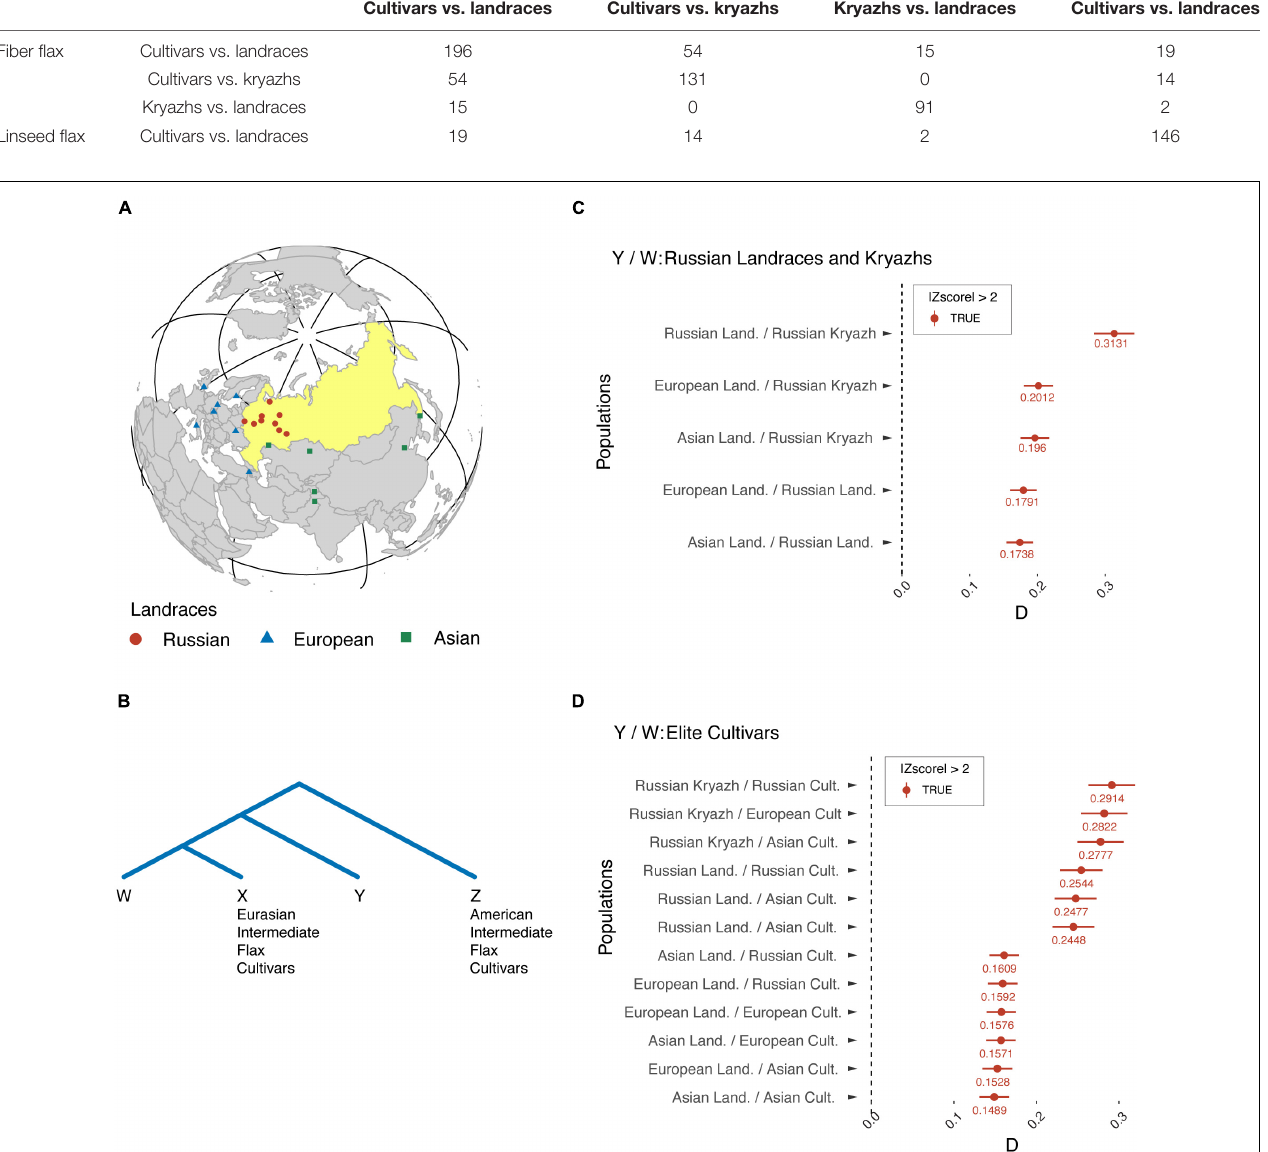
FIGURE 6 | Signatures of gene flow from European and Asian landraces into Russian landraces and kryazhs, as well as from kryazhs and landraces to modern flax fiber cultivars. (A) Geographic sites of landrace origin/release. (B) Four populations used to calculate D -statistics. Z , American intermediate flax cultivars; X , Eurasian intermediate flax cultivars; W , the second sister population; Y , the introgressing population. (C) D -statistics diagram where population W corresponds to kryazhs or Russian landraces, while population Y stands for landraces of different origin. (D) D -statistics diagram where population Y corresponds to either kryazhs or landraces of different origin. Population W represents elite fiber flax cultivars and breeding lines.